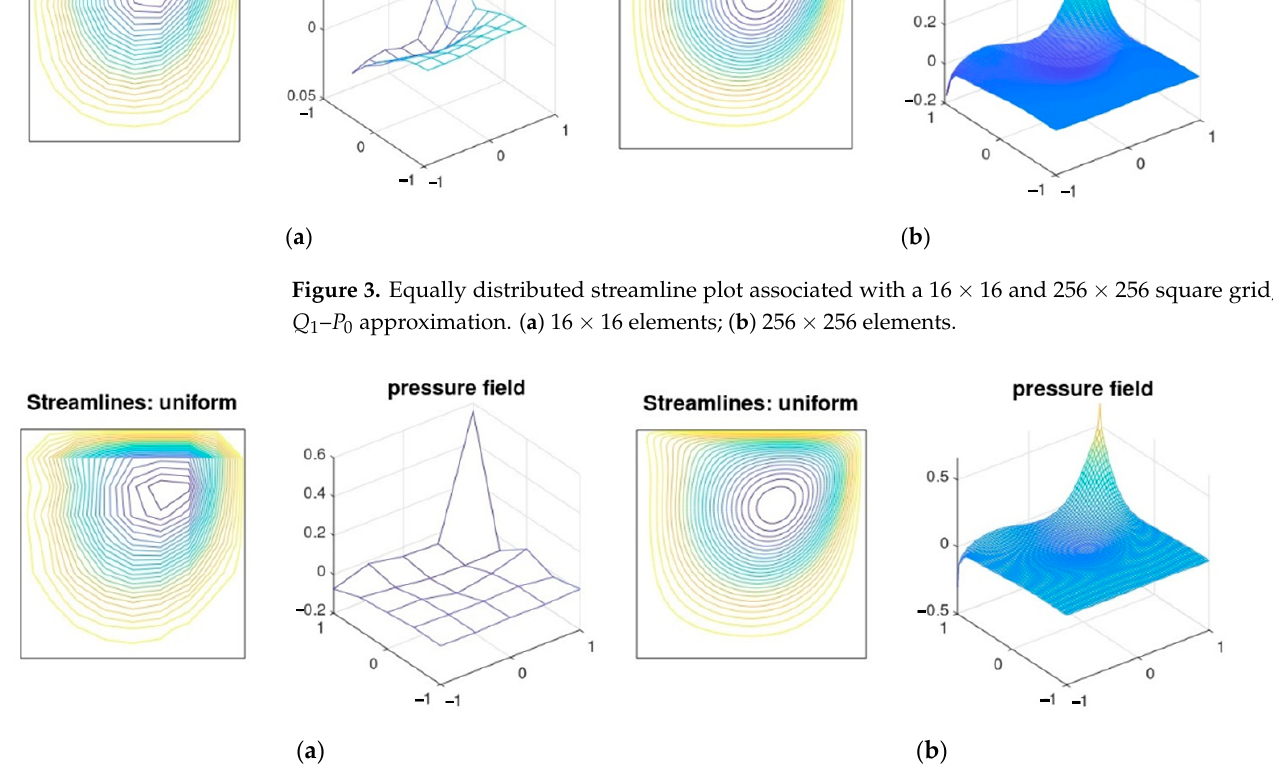
Figure 4. Equally distributed streamline plot associated with a 16 × 16 and 256 × 256 square grid, Q 2 – Q 1 approximation. ( a ) 16 × 16 elements; ( b ) 256 × 256